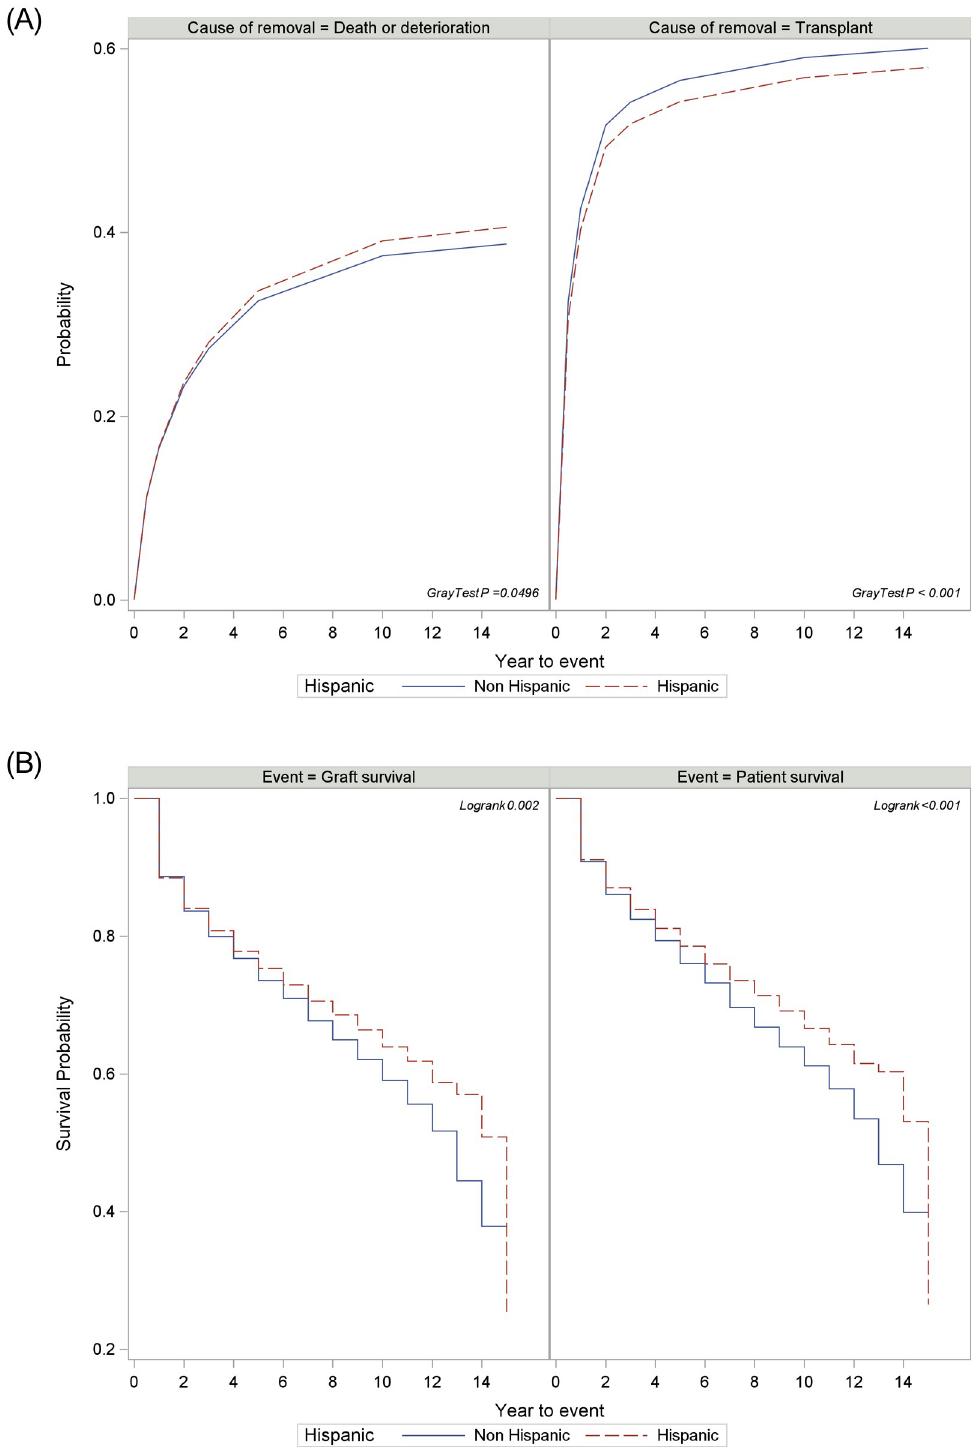
Fig 3. A: Cumulative incidence of removal due to death or deterioration and liver transplant by Hispanic (1:1 matched cohorts); B: Kaplan Meier patient and graft post-transplant survival by Hispanics and others (1:1 matched cohorts). The groups were matched for region, age, sex, BMI, MELD score, highest education, insurance and employment.